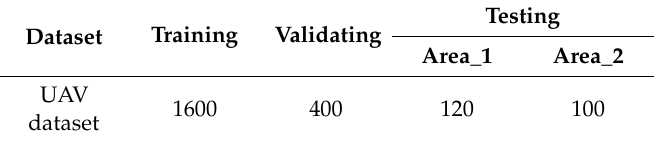
Table 1. The number of samples for training, validating, and testing from our UAV datasets.